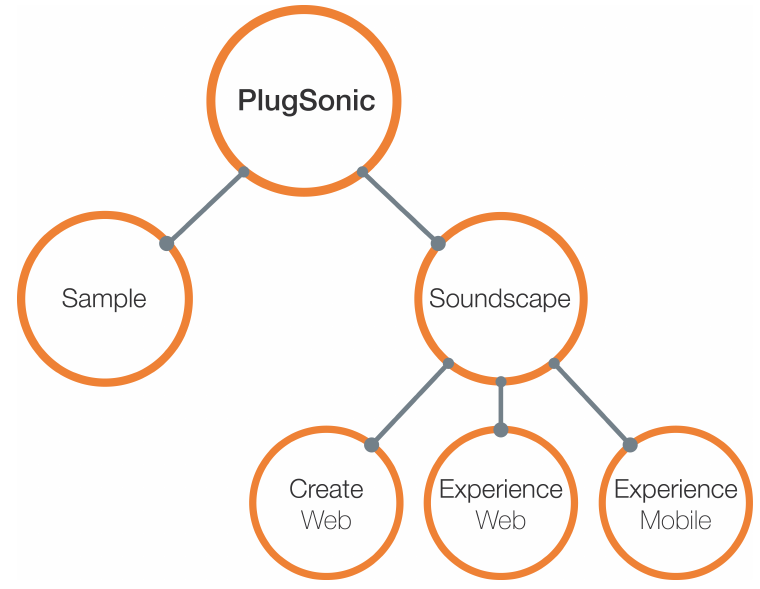
Figure 2. Apps of the PlugSonic Suite